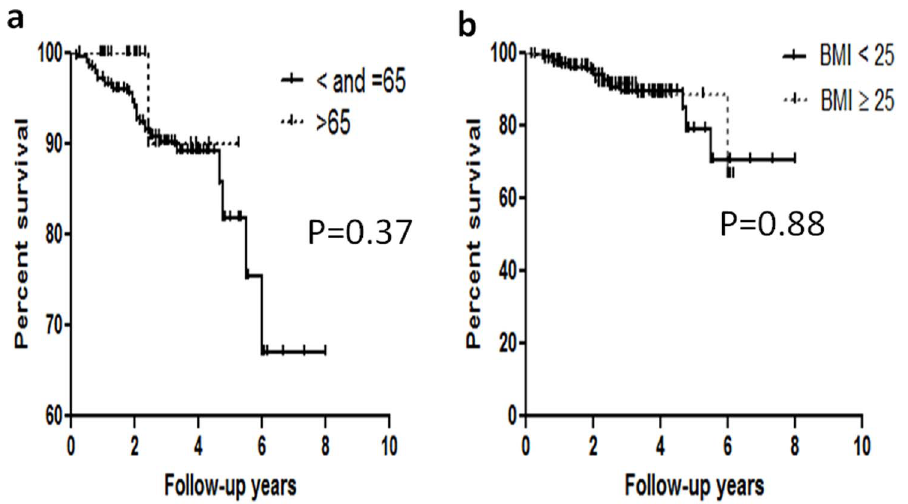
Figure 1. Cumulative overall survival in hepatocellular carcinoma (HCC) patients stratified by age. There was no statistically significant difference in the overall survival rate between young ( , =65 years old) and elderly patients (P=0.37). The overall survival rates were not significantly correlated with body mass index (BMI) (P=0.88).